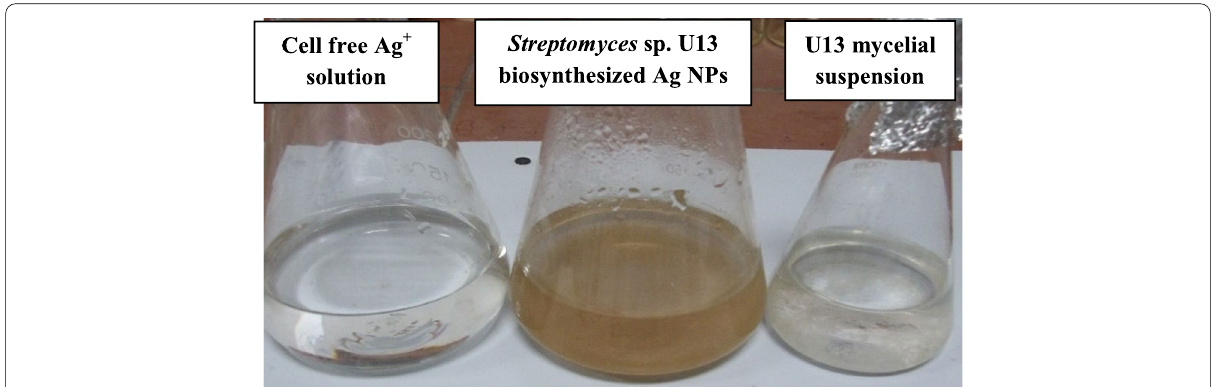
Fig. 2 Biosynthesis of Ag NPs by Streptomyces sp. U13 actinomycete strain showing change of colour to